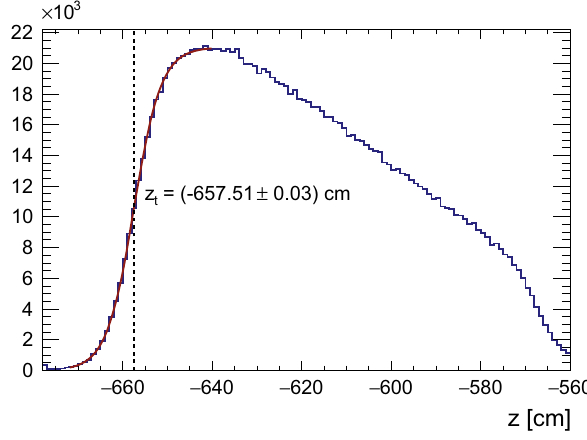
Fig. 5 The distribution of z positions of closest approach for TPC tracks extrapolated to the beam track. Only tracks whose distance to the beam track is within extrapolation uncertainty were selected. The red line shows fitted rising edge and the position of the half maximum was taken to be the target upstream z position